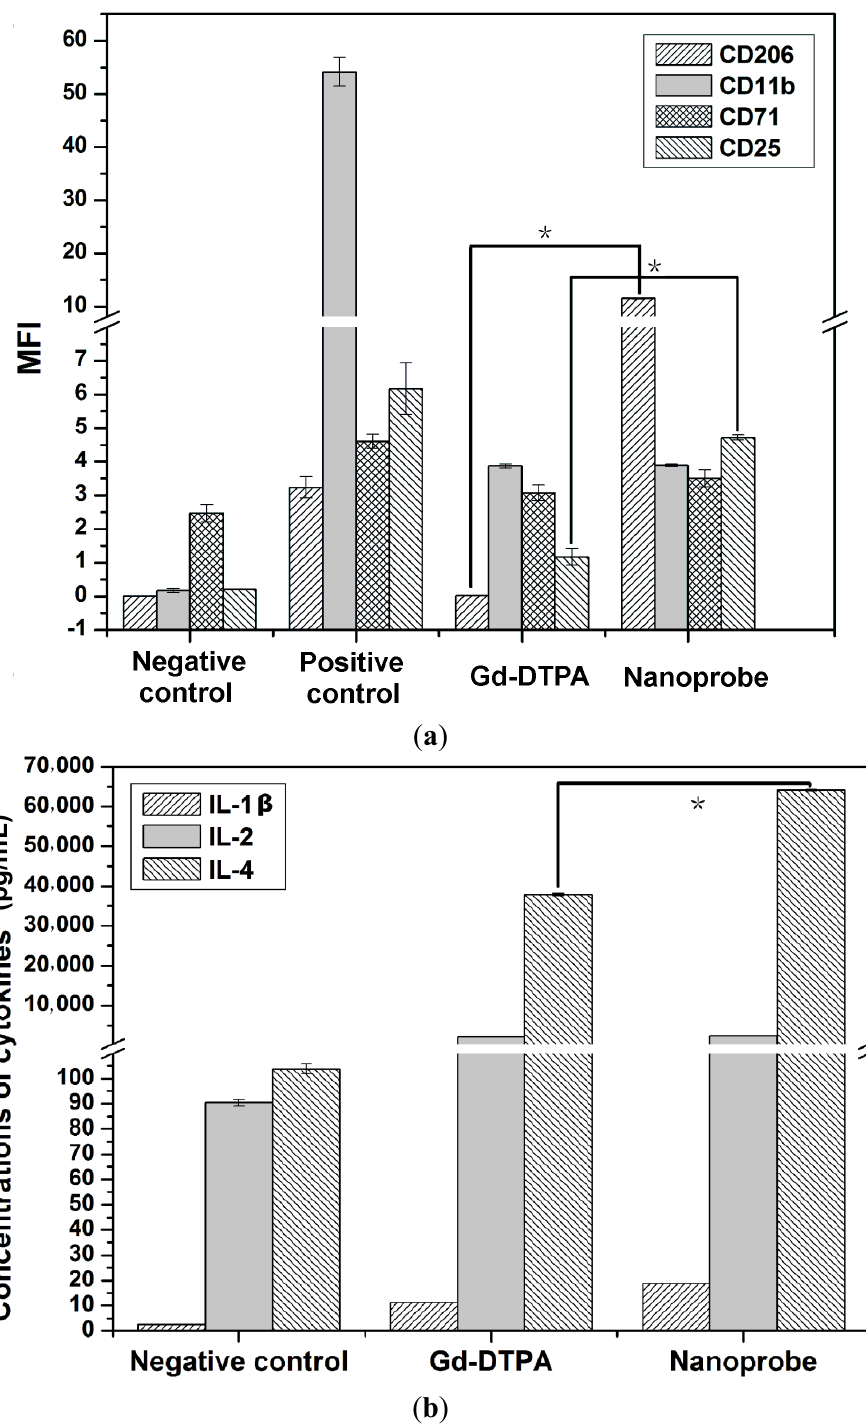
Figure 4. Toxicity of the immune response measured by flow cytometry 24 h after injection in Balb/c mice (20 μmol/kg, mean ± SD; n = 5). ( a ) The expression levels of CD206, CD11b, CD71 and CD25 in peripheral blood; and ( b ) The levels of IL-1β, IL-2 and IL-4 in serum. * p < 0.05 compared with the Gd-DTPA